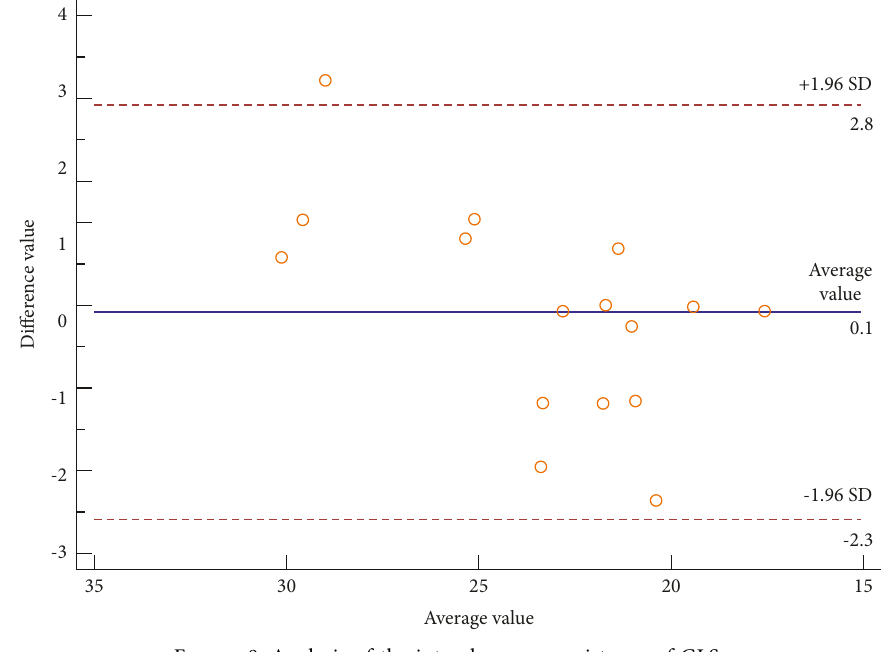
Figure 8: Analysis of the intraobserver consistency of